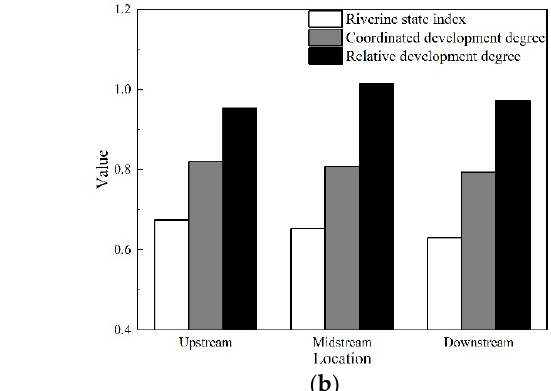
( b ) Figure 5. The overall results of the coordinated development degree assessment for the Lhasa River from 2011 to 2014. The specific indicators include: ( a ) Natural and social functions; ( b ) the riverine state index, coordinated and relative development degree. The spatial variability of coordinated development degree assessment from the river’s upstream to downstream can be seen in Figure 4a,b. Natural function values of 0.664, 0.654, and 0.615 indicate a good status, while they gradually decreased from up- stream to downstream. Social function results also decreased from upstream to